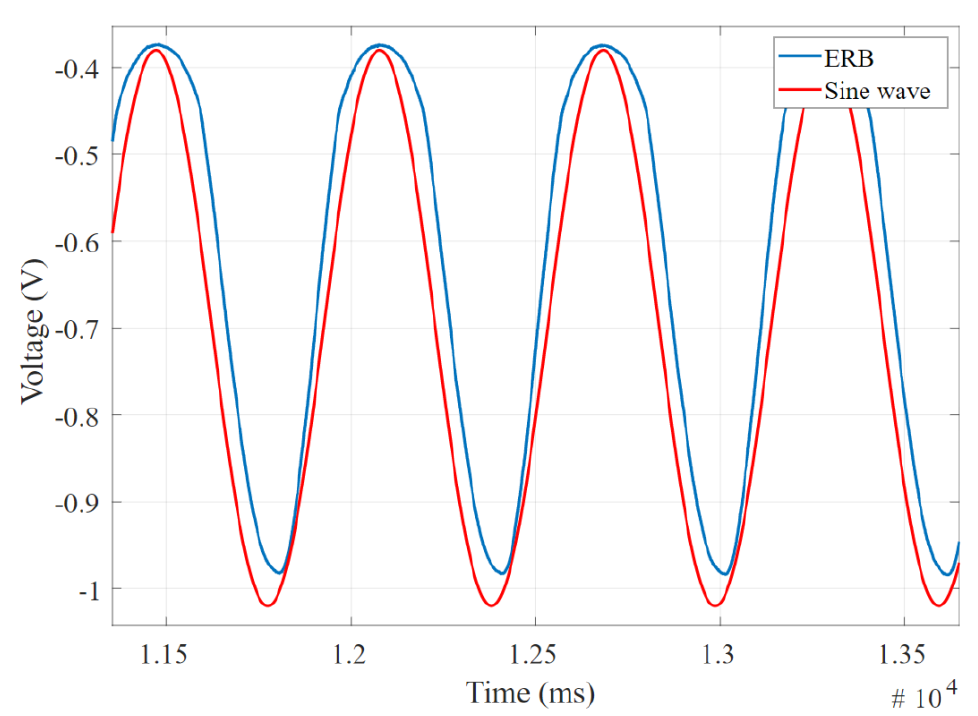
Figure 16. The electro-resistive band (ERB) output and expected sine wave showing low phase difference and high correlation